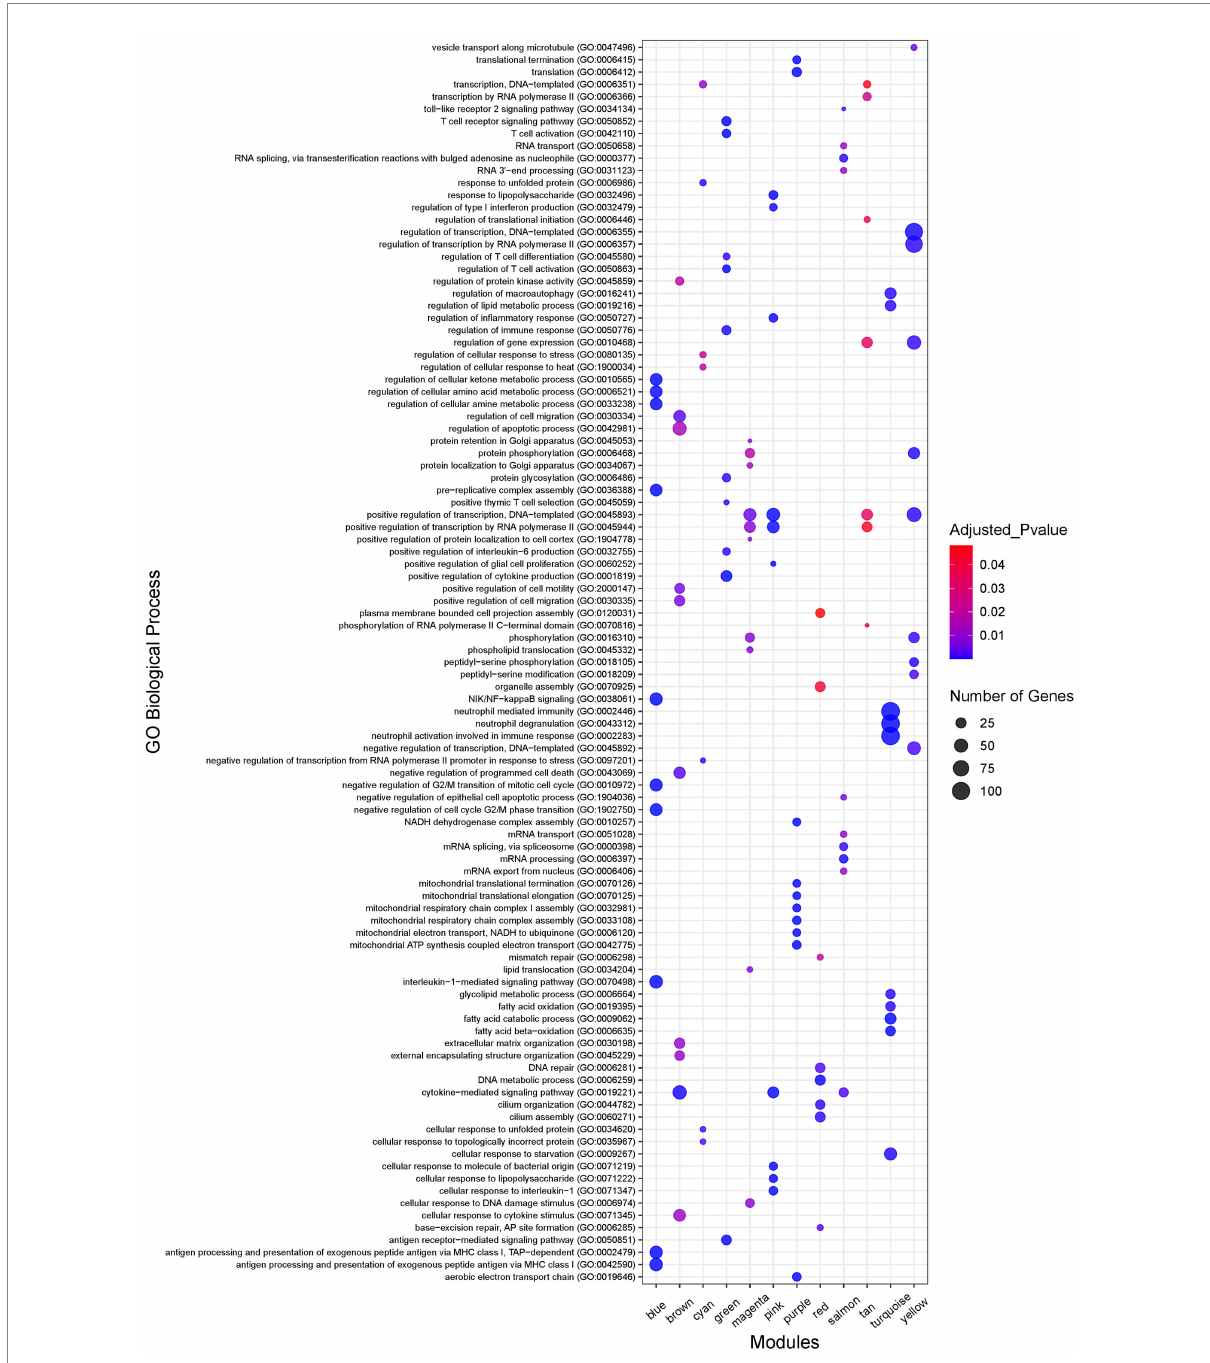
FIGURE 6 Dot plot of functional enrichment analysis. The top 10 significant biological process GO terms of the non-preserved modules. The y -axis represents significant enriched GO terms and the x -axis represents module name. Color and size of each point represent adjusted p -value and number of genes for each term,